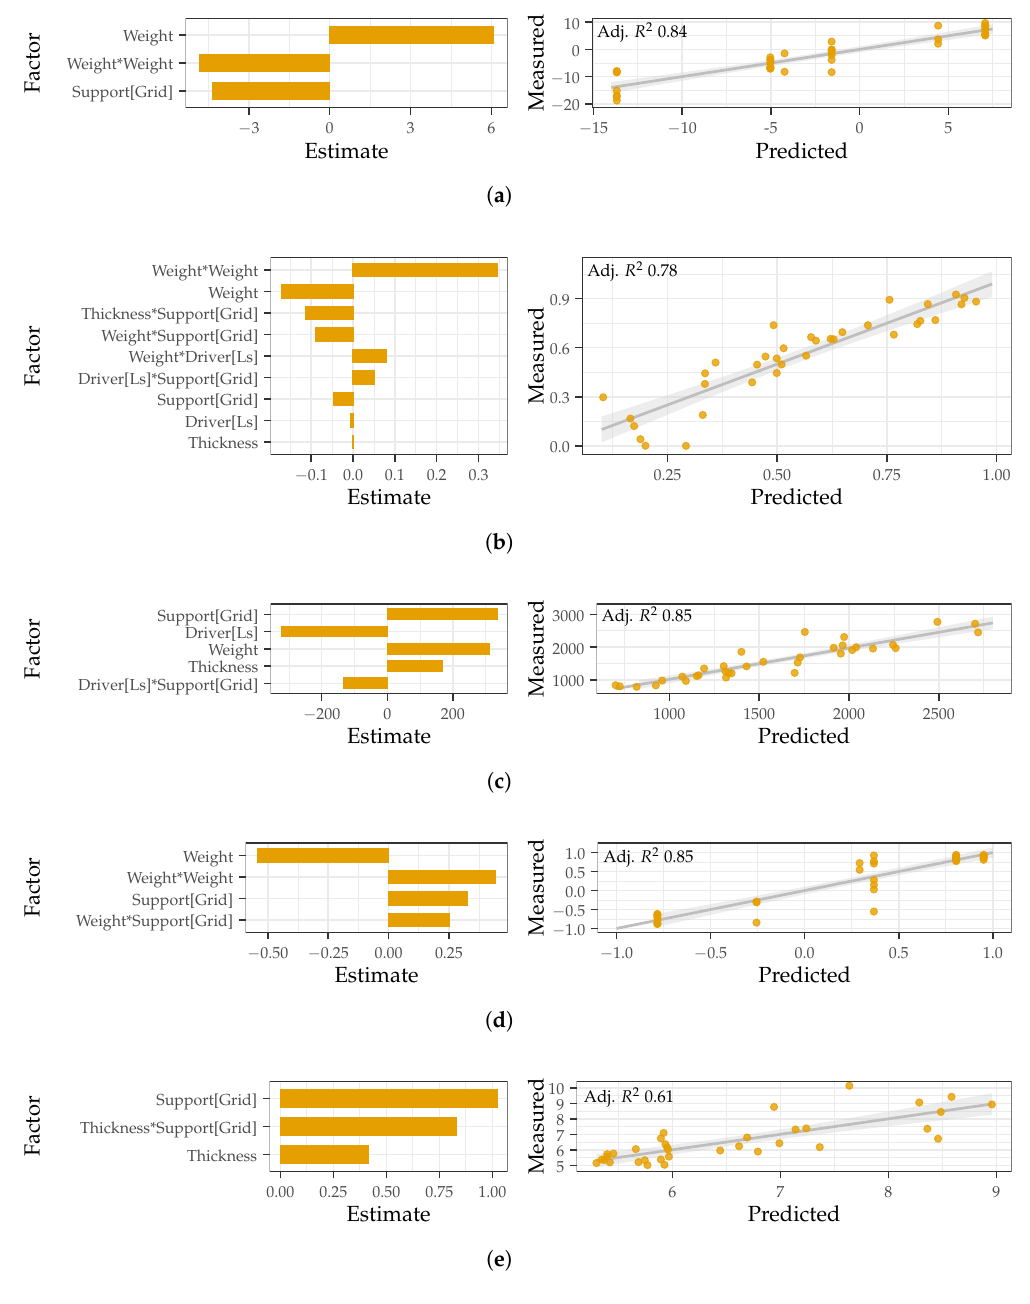
Figure 4. The significant factor estimates ( left ) and predicted versus measured plots ( right ) for the ( a ) center position slope, ( b ) center position R-squared, ( c ) Euclidean distance, ( d ) correlation, and ( e ) SNR susceptibility